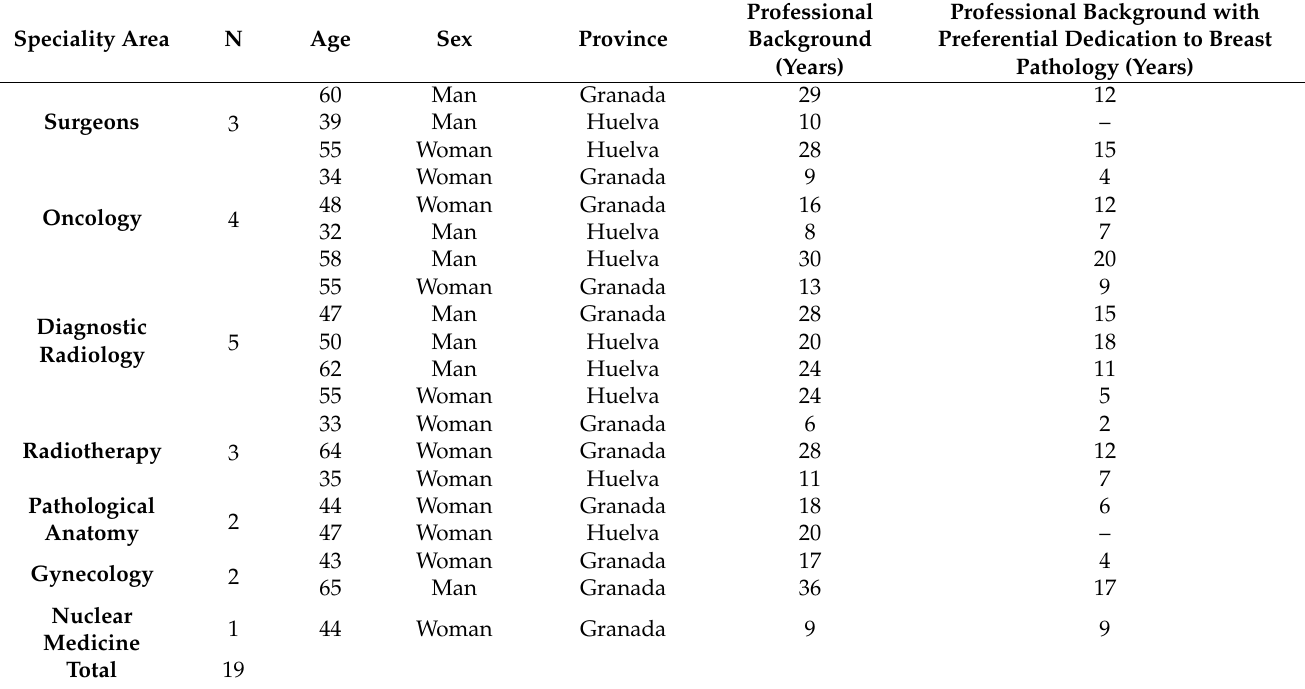
Table 1. Professional profiles recruited for the